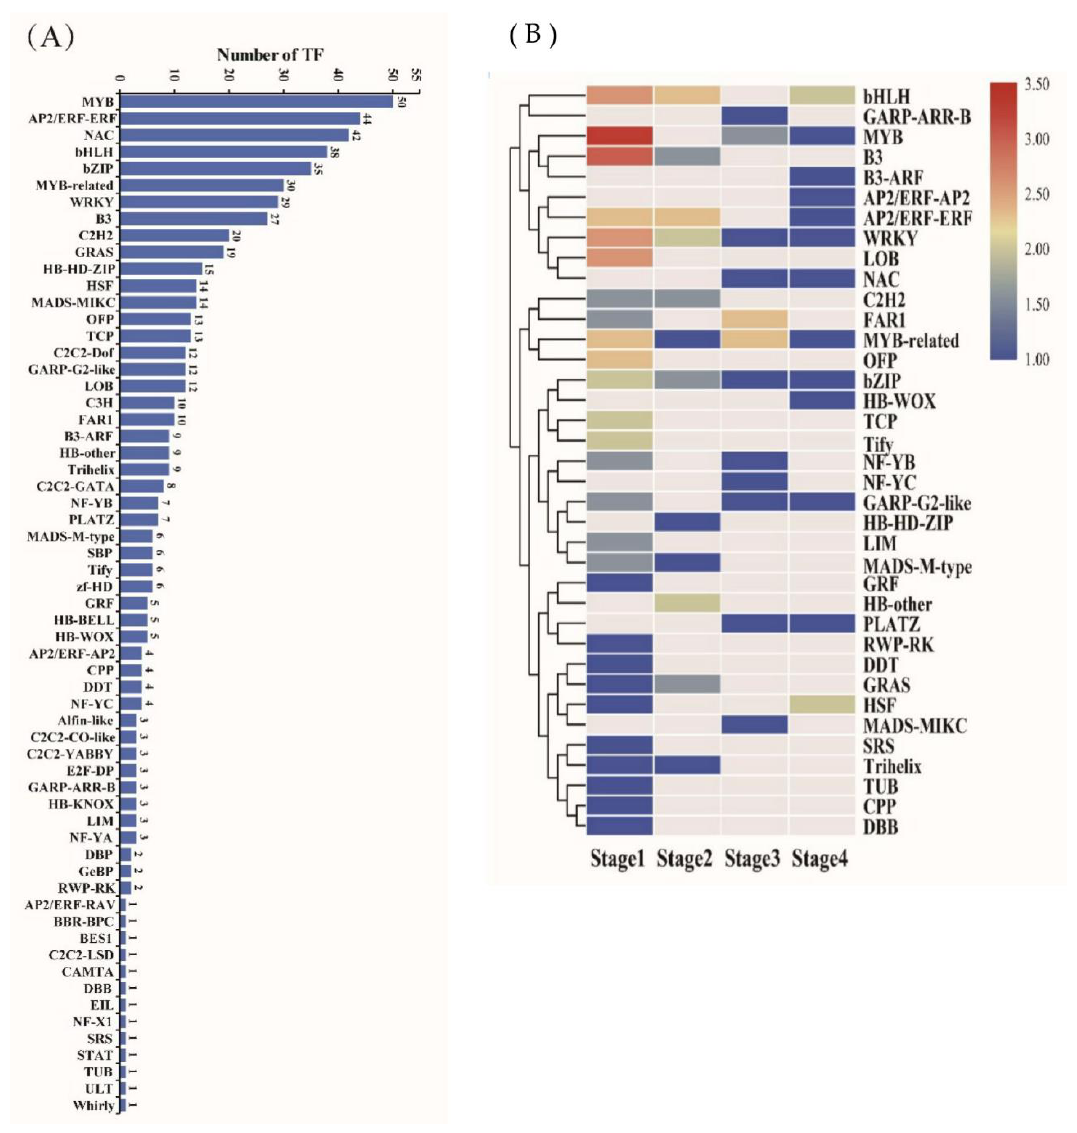
Figure 3. Characterization of transcription factors (TFs) differentially expressed during barley grain development. ( A ) Number of transcription factors (TFs) differentially expressed between any two stages of barley grain development. ( B ) Characterization of TF in each expression pattern.